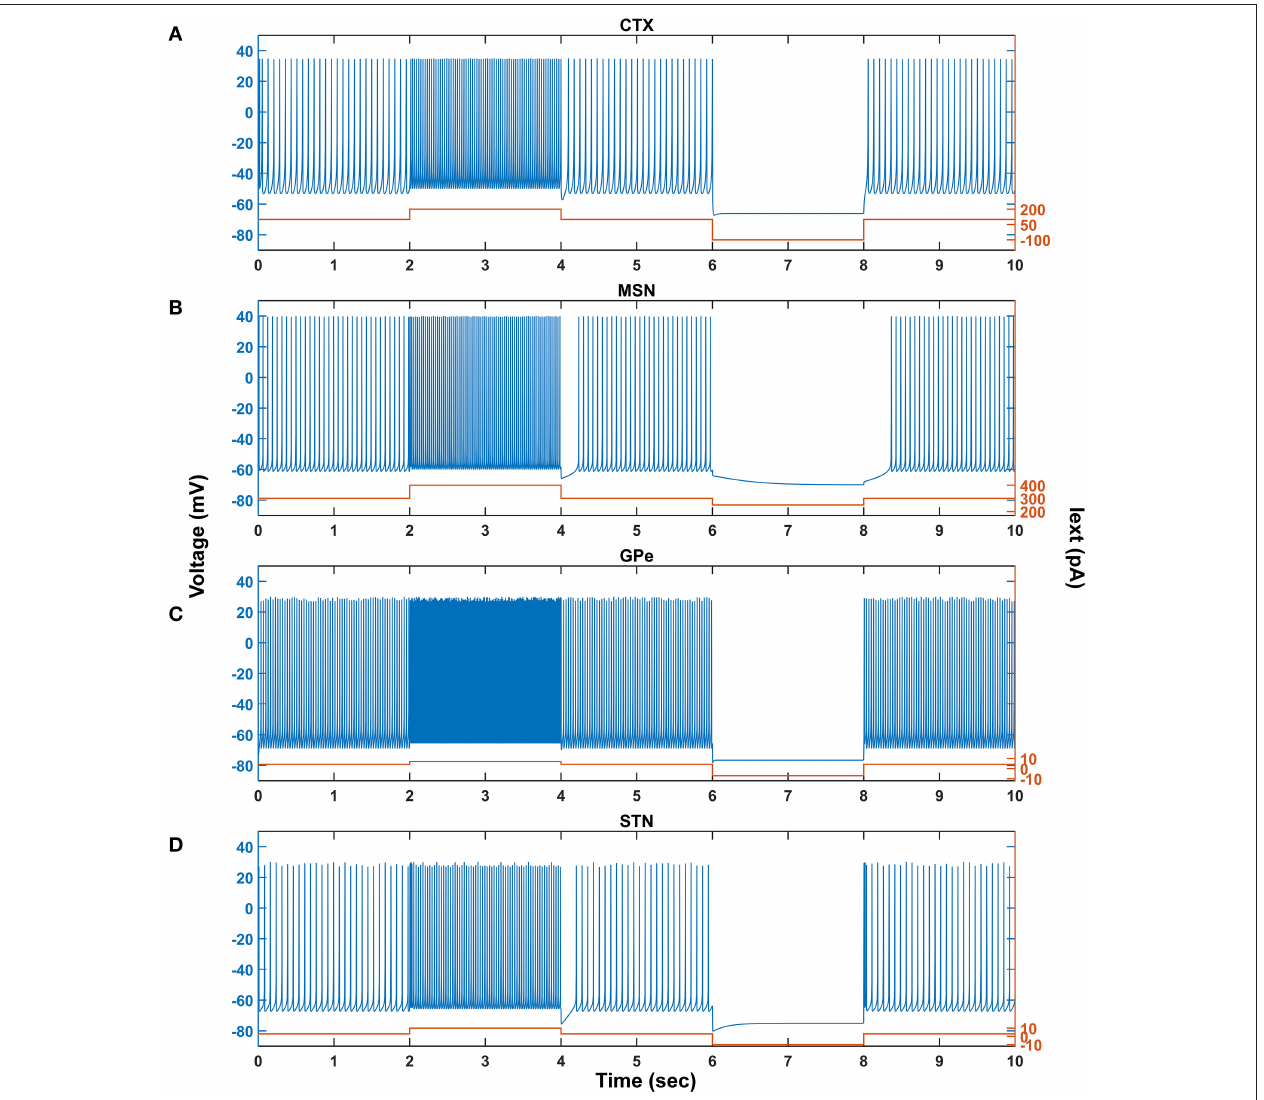
FIGURE 2 | Characteristic behavior of individual neurons from a single isolated neuron. Characteristic behavior of individual CTX (A) , MSN (B) , GPe (C) , and STN (D) neuronal types. CTX, cortex; MSN, medium spiny neuron; GPe, globus pallidus externa; STN, subthalamic nucleus; Iext, external current; pA, picoampere; mV, millivolt; sec,